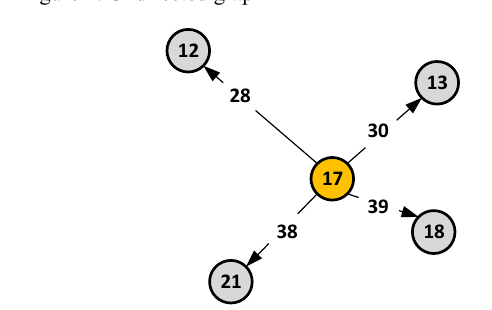
Figure 2. Directed